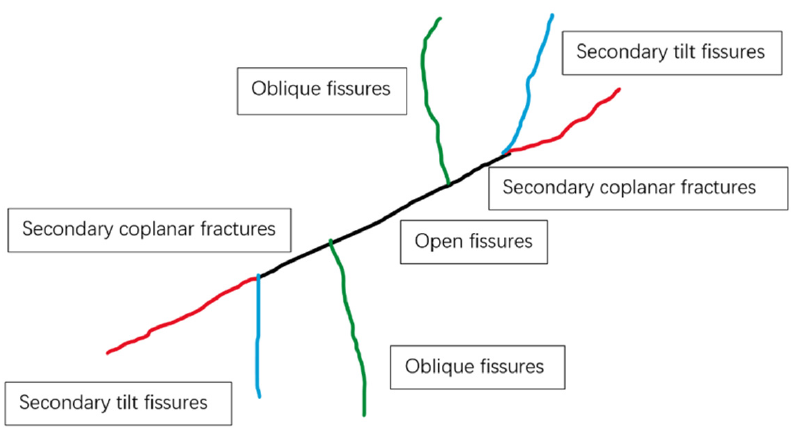
Figure 11. Fracture expansion